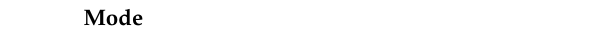
Table 1. Current drain by CC1350. Mode